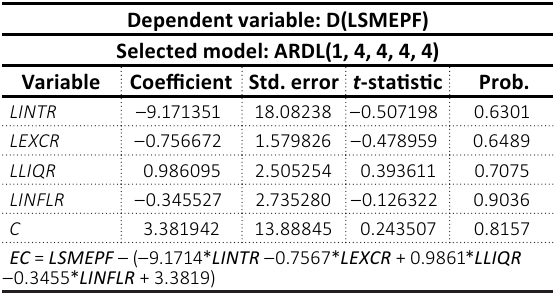
Table 4. ARDL long-run form